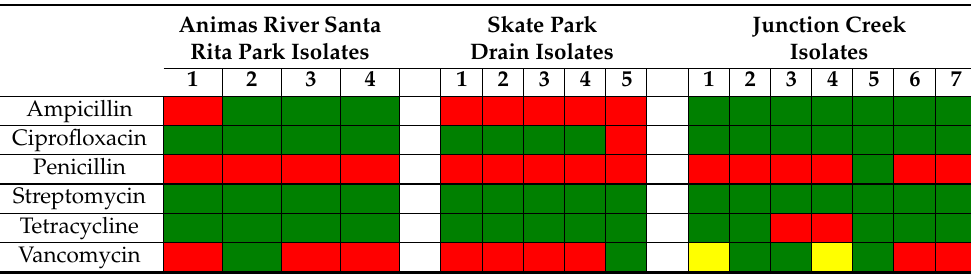
Table 2. Heat map indicating antibiotic resistance profiles of Animas River watershed bacterial isolates tested during February–March 2015 (red indicates antibiotic resistance; green indicates antibiotic susceptibility; yellow indicates some resistant